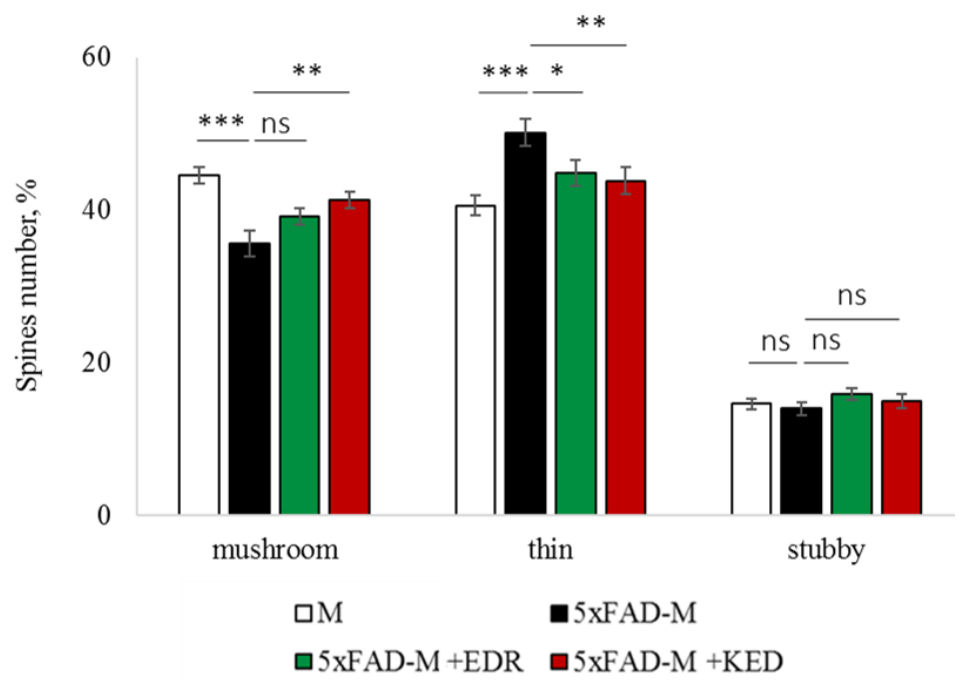
Figure 4. Relative spines number of CA1 secondary dendrites in 5 month-old M and 5xFAD-M mice, injected with physiological solution, EDR peptide, KED peptide. *, **, ***— p < 0.05, p < 0.01, p < 0.001 compared to the 5xFAD-M mice, injected with physiological solution, ns—non-significant.